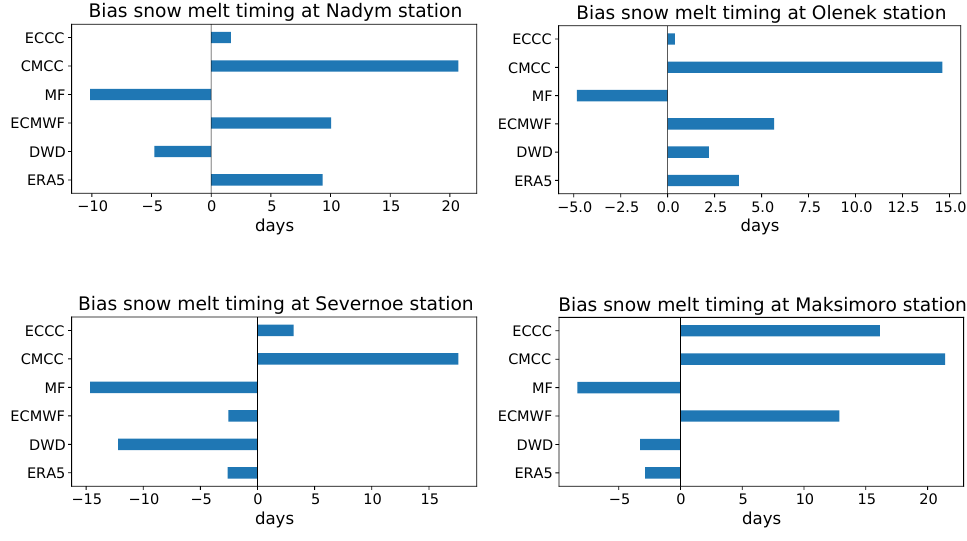
Figure 8. Difference in days of the average melting date at the grid-point closest to the station from the seasonal forecasting systems and ERA5 compared to station data. The melt timing is defined by the time when one-third of the maximum snow depth is